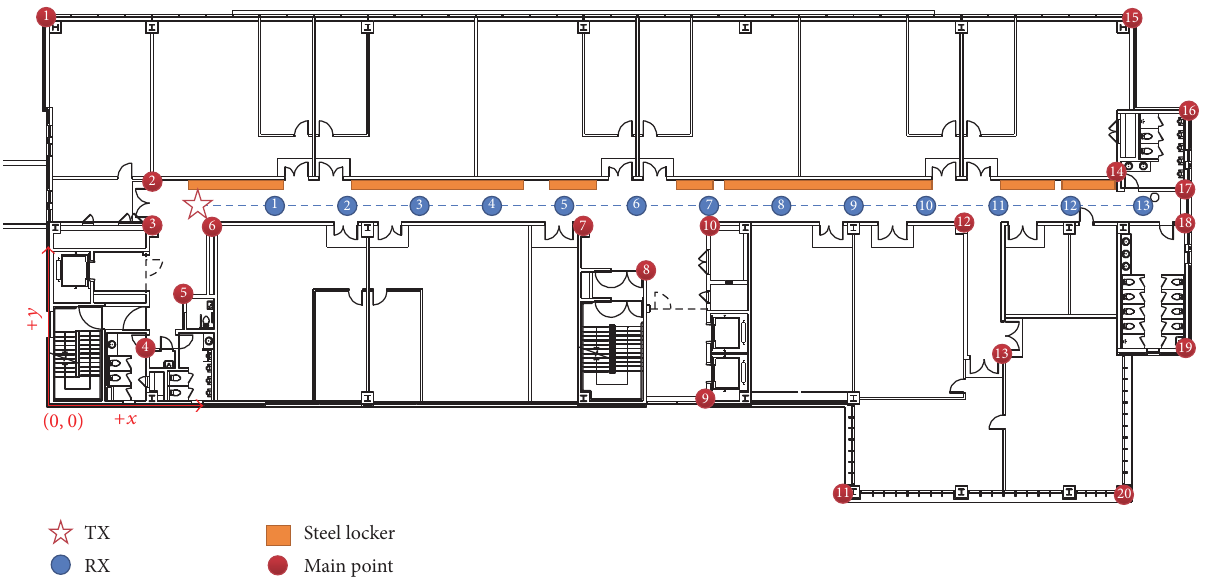
Figure 2: Map of the test site. The origin of the coordinate is at the lower left.